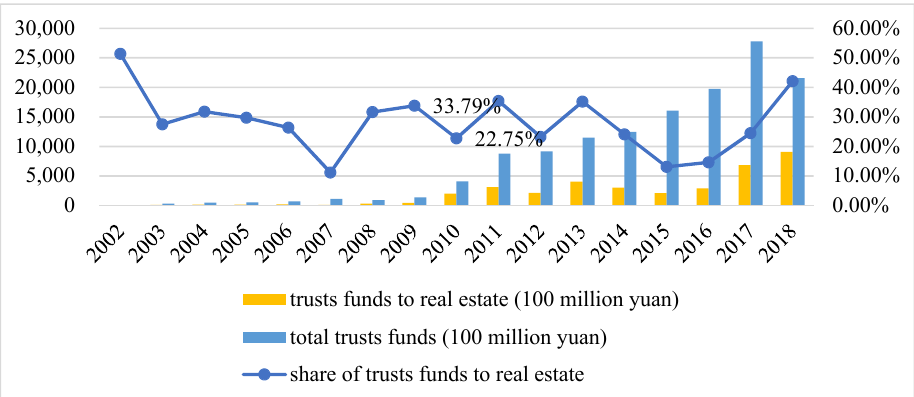
Figure 8. Total amount and shares of trust funds from 2002 to 2018. Source: China Trustee Association, CTA.